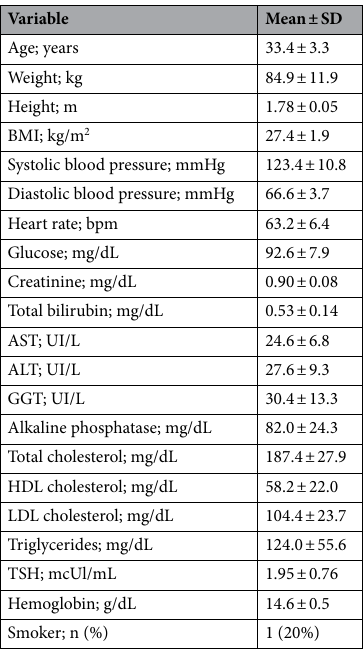
Table 1. Baseline characteristics of the study subjects. Values are means ± SD or frequencies and percentages, as indicated. n = 5. AST, aspartate aminotransferase. ALT, alanine aminotransferase; GGT, gamma-glutamyl transferase, TSH, Thyroid-Stimulating Hormone; HIV, human immunodeficiency virus.